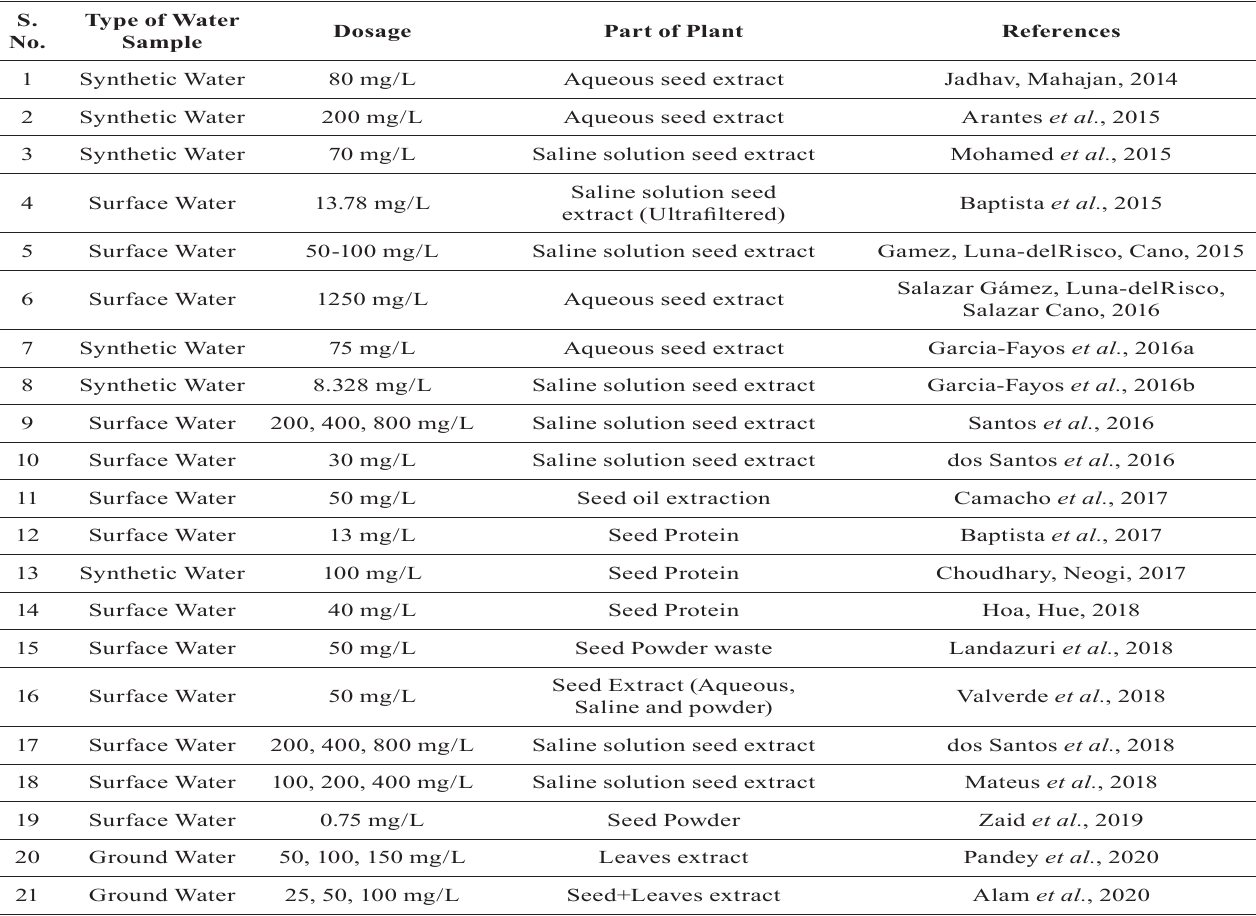
TABLE I - C oagulant studies using different parts of Moringa oleifera plant S.